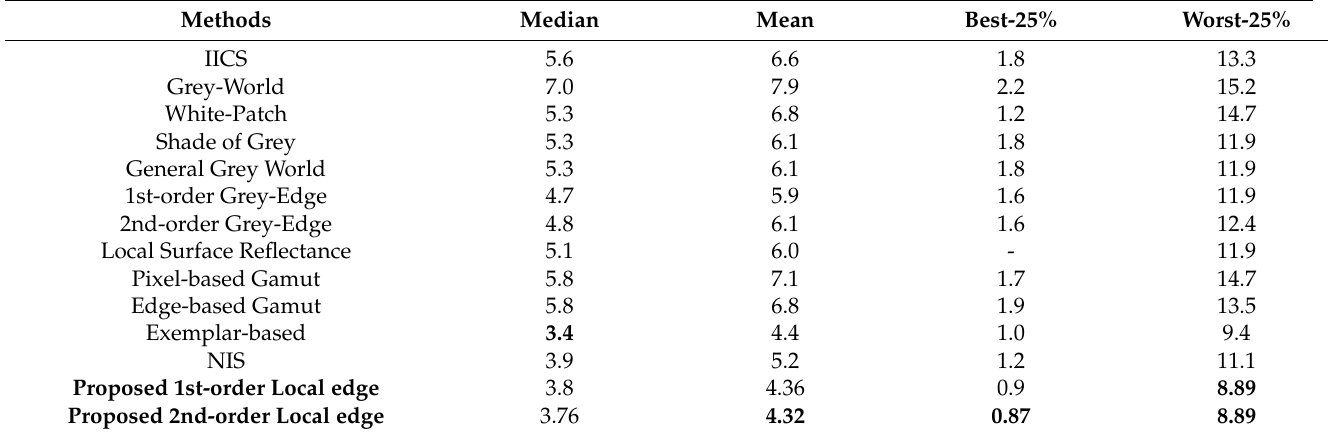
Table 5. Performance of different color constancy methods on the SFU Grey-Ball